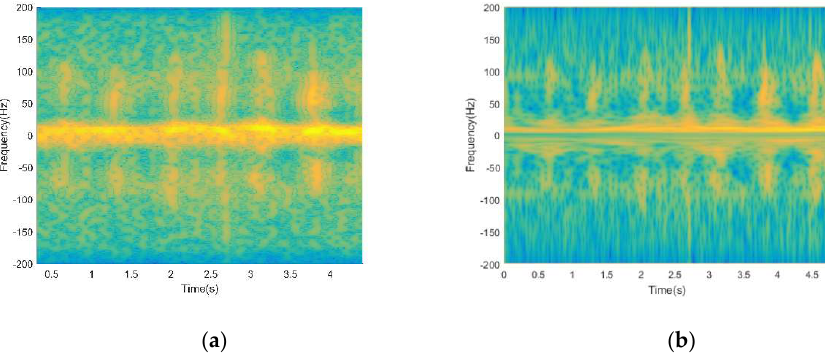
Figure 5. ( a ) Time-frequency distribution of signal processed by S-method; ( b ) time-frequency distribution of signal processed by Energy Aggregation.